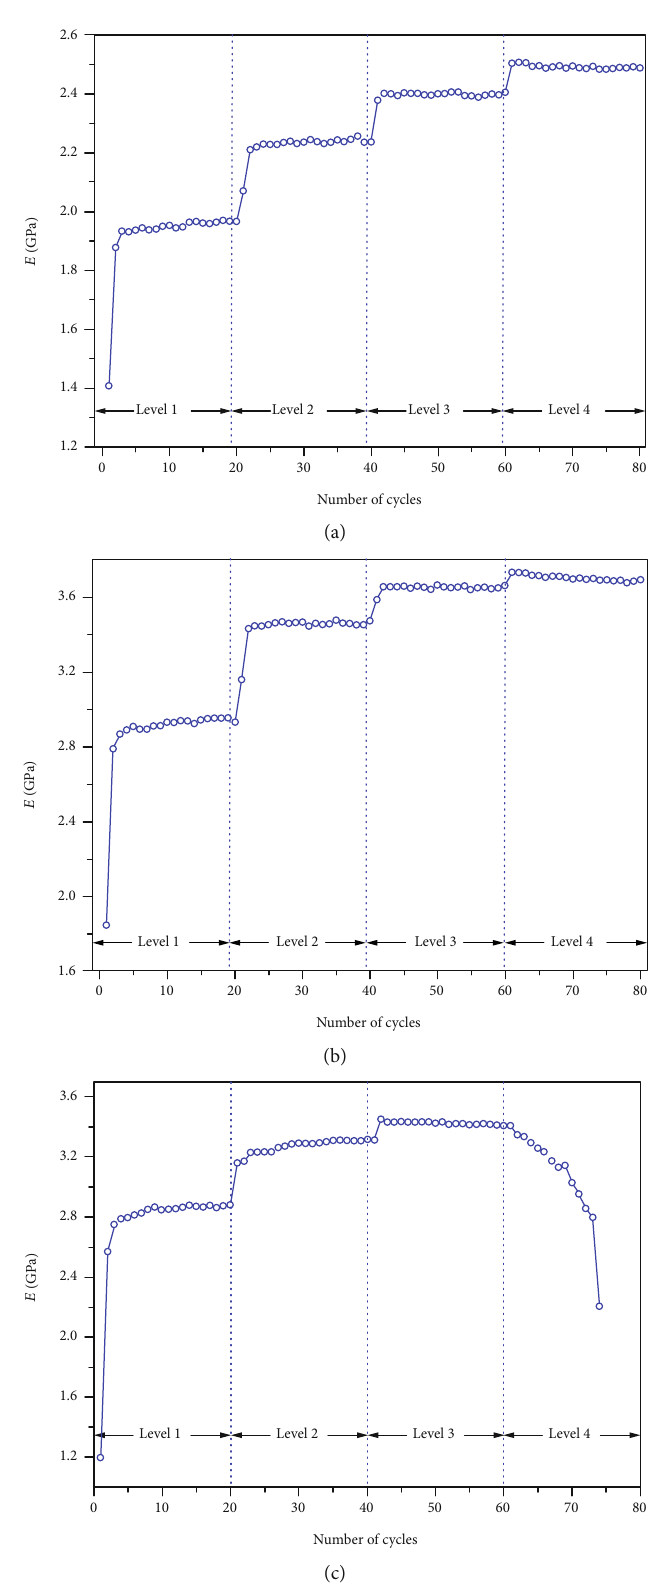
Figure 5: Evolution of Young ’ s modulus with the number of cycles under di ff erent frequencies: (a) 0.1Hz; (b) 0.2Hz; (c)